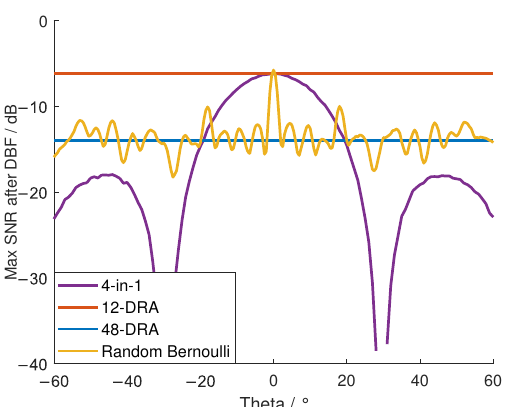
Figure 11. The spatial sensitivity of random encoding structure with input SNR = − 20 dB.